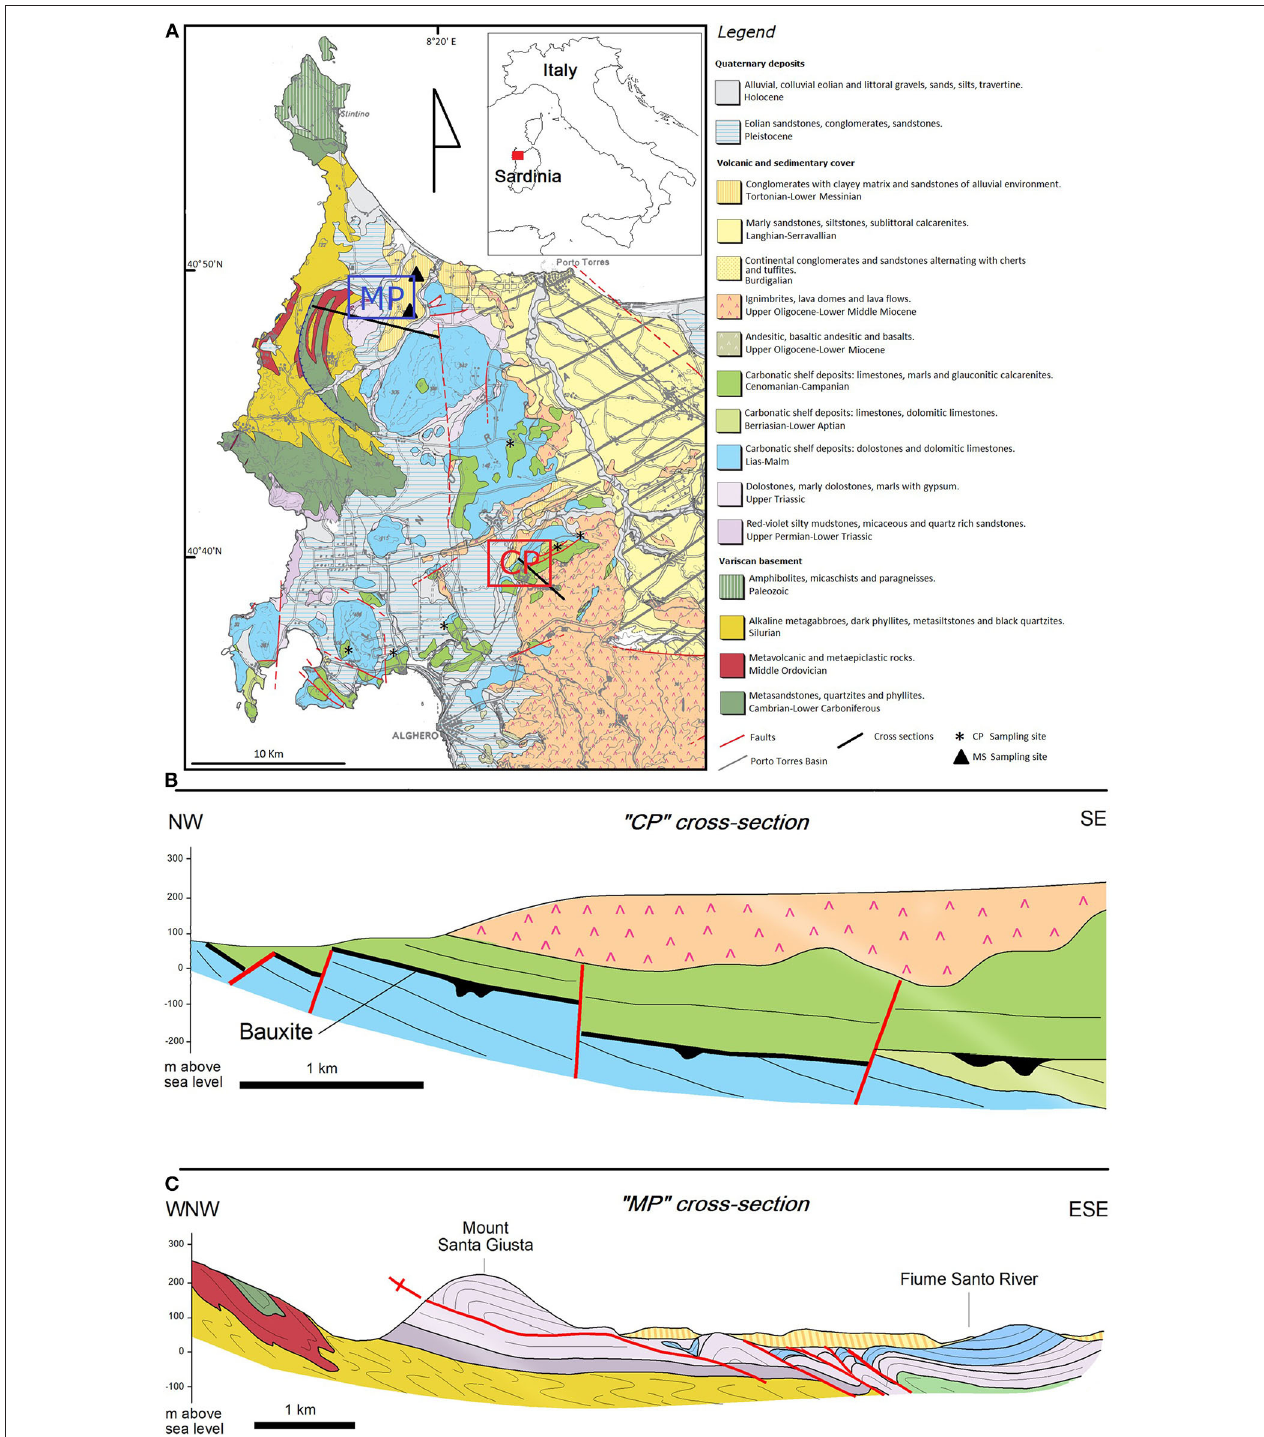
FIGURE 1 | (A) Geological map of NW Sardinia showing the areas from which the analyzed Messinian and Cretaceous palaeosols (MP and CP, respectively) were sampled [modified after Carmignani et al., 2016]. (B) Geological cross section of the bauxite filling the stratigraphic gap between Upper Jurassic and Upper Cretaceous. (C) Geological cross section of Messinian alluvial deposits hosting MP palaeosols unconformably capping the deformed Mesozoic cover. intercalations of marlstone. There exists a stratigraphic gap by an almost continuous horizon of karstic bauxite, and. it embracing the Albian–Turonian interval, related to a period is constrained, on paleontological and micropaleontological of emergence ( Mameli et al., 2007). This gap is represented bases ( Philip et al., 1978; Philip, 1983) between the Aptian and Frontiers in Earth Science | www.frontiersin.org